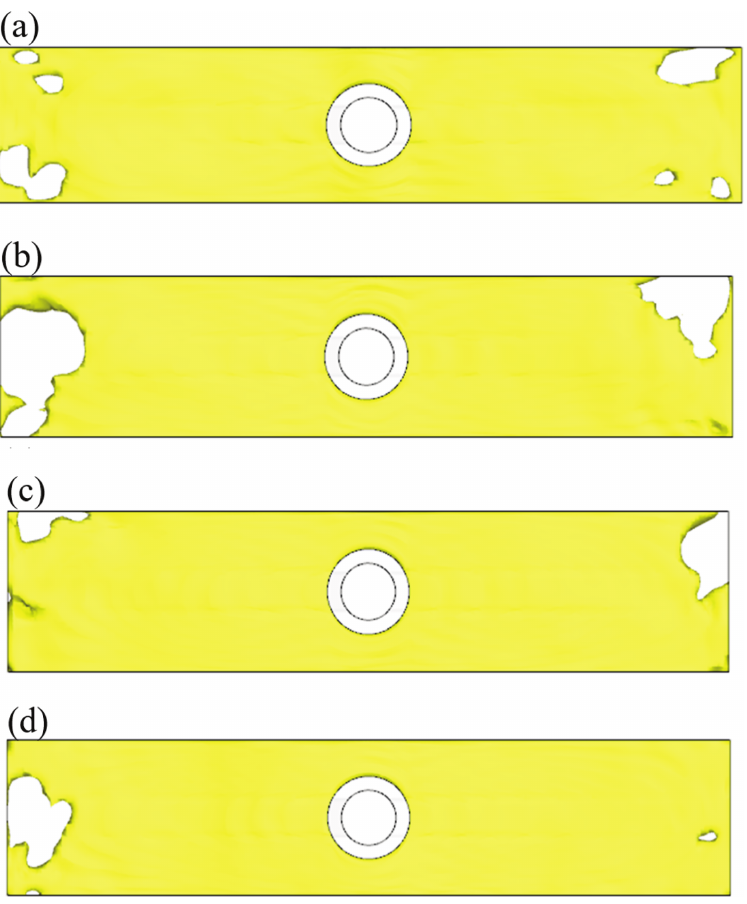
Figure 12: The slag “ eye ” regions in the simula- tion with casting speed of 1.3m/min at different